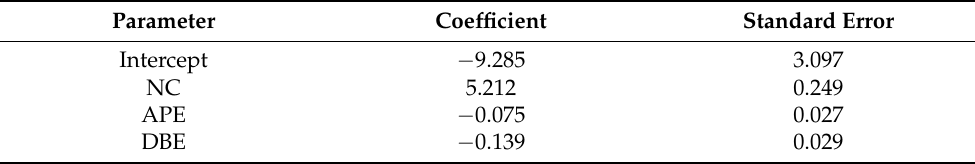
Table 1. Regression coefficients and intercepts of the key parameters in this study.